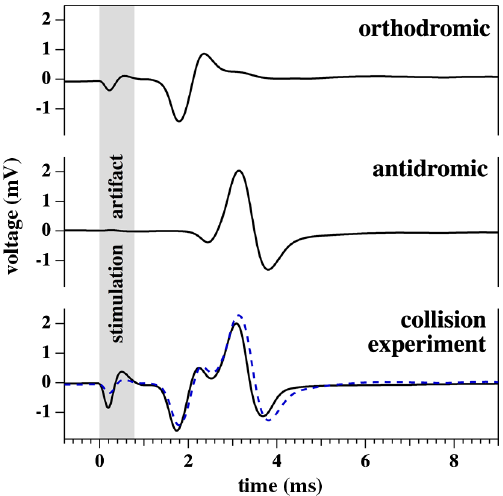
FIG. 6. Example of the pulse collision experiment in the ventral cord of an earthworm (sample #7 in Table I). Top: Action potential propagating orthodromically after stimulation at the top end of the nerve. Center: Action potential propagating antidromi- cally after stimulation at the bottom end of the nerve. Bottom: Both action potentials generated by simultaneous stimulation at both ends (solid line). For comparison and a guide for the eye, the dashed line represents the sum of the individual pulses. This signal is similar to the observed trace. The region shaded in grey shows the stimulation artifact.